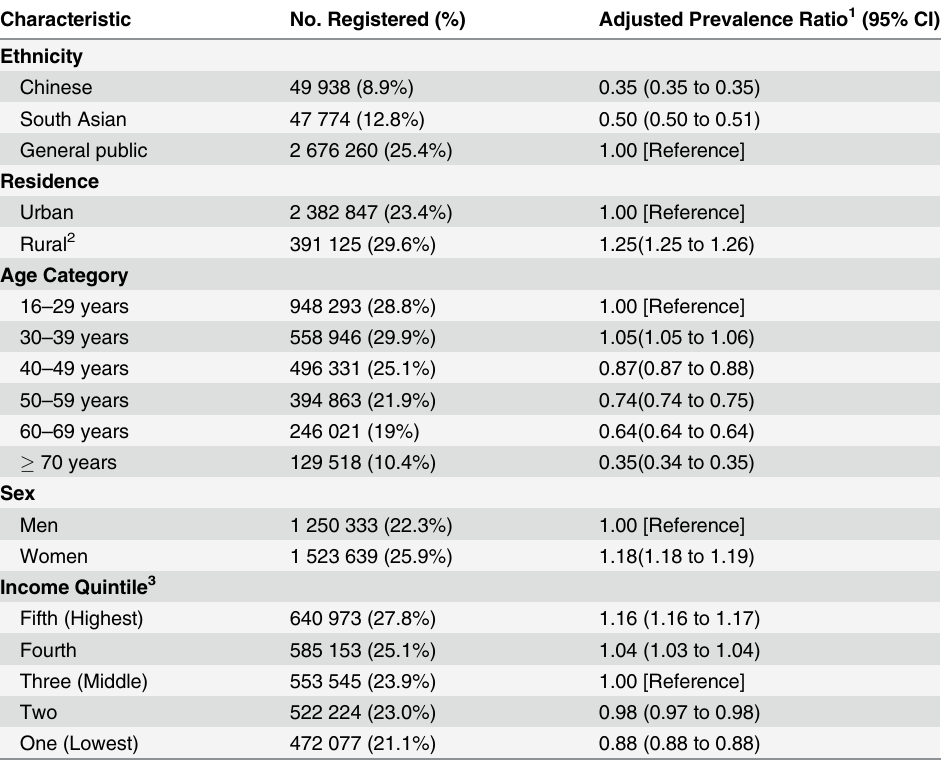
Table 2. Factors associated with Donor Registration (Cross-sectional